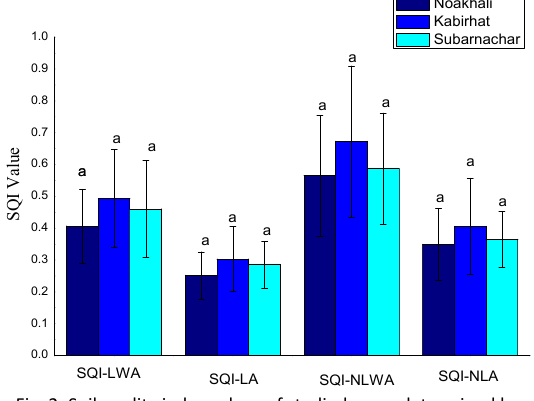
Fig. 2: Soil quality index values of studied areas determined by various methods Fig. 3: Major contributors of SQI ‐ LWA in three different Upazila